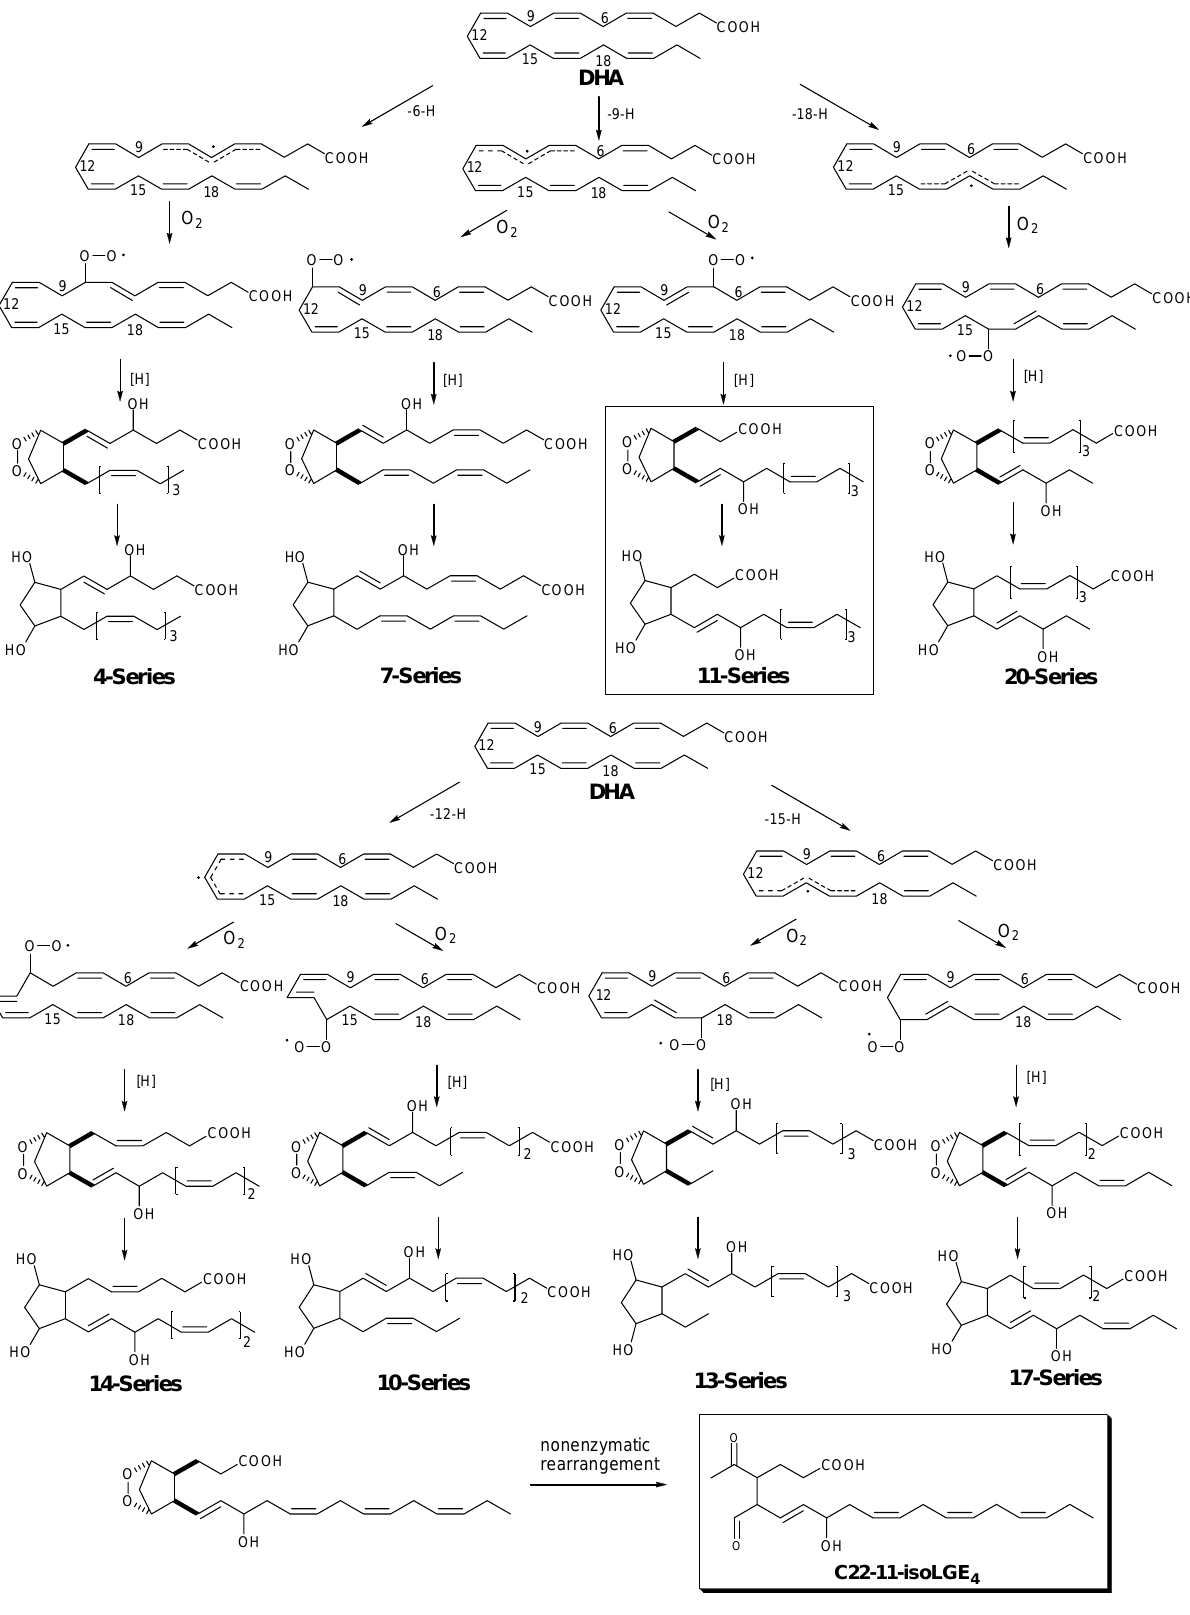
-C22-isoprostane and C22-isolevuglandin (11-isoLGE Scheme 3. F 4 nonenzymatic peroxidation of docosahexaenoic acid